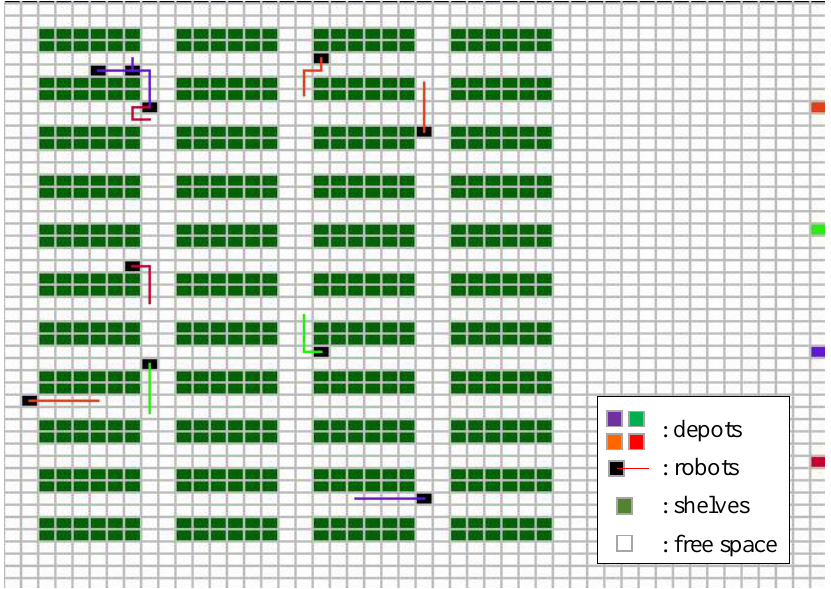
Figure 5. Logistics environment simulation in grid form. In the multiple block structure, the picking UAV is represented in a black box. The lines are robot paths with same color of the starting